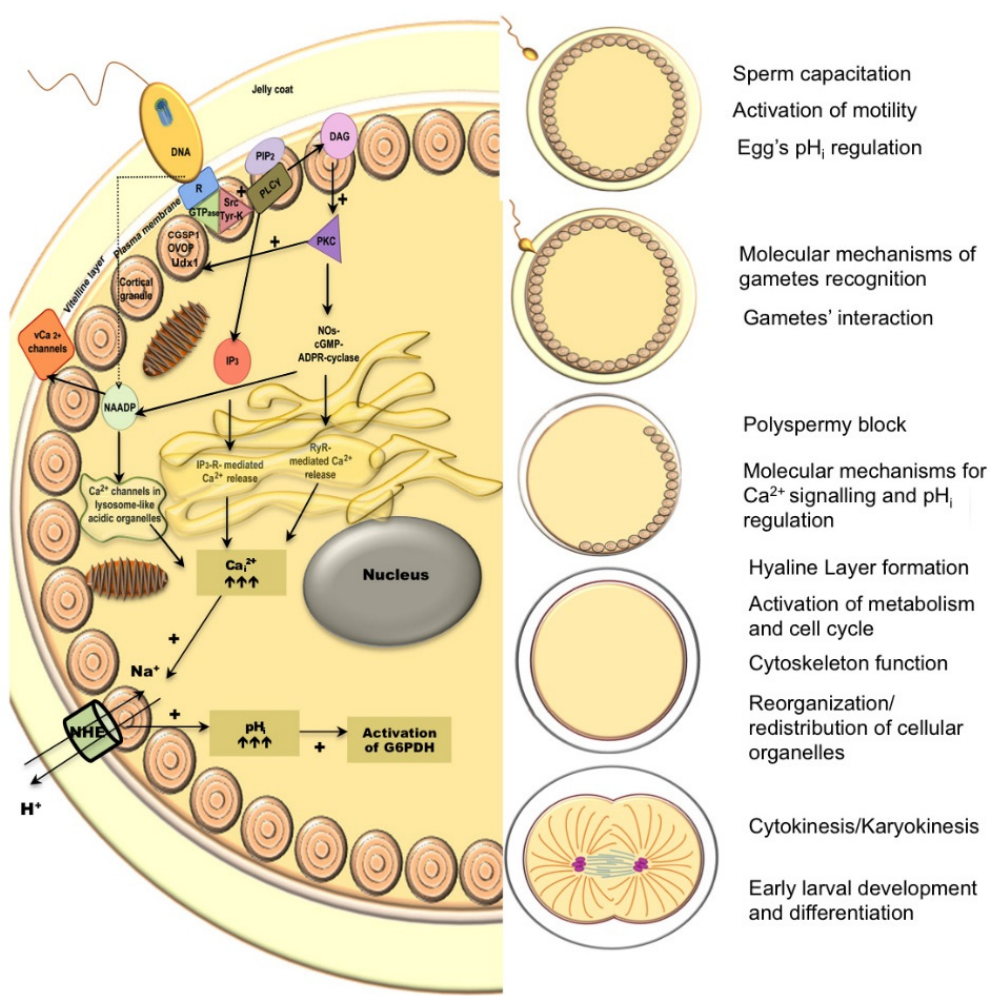
Figure 2. Overview of the main mechanisms at fertilization prone to be susceptible under climate change scenarios. AChR: nicotine acetylcholine receptors; ADPRcyclase: ADPrybosylcyclase; CGSP1: cortical granule serine protease 1; DAG: diacylglycerol; GTPase: G protein; G6PDH: glucose-6- phosphate dehydrogenase; IP 3 : inositol triphosphate; IP 3 R: IP 3 -receptors; NAADP: nicotinic acid adenine dinucleotide phosphate; NHE: Na + -H + exchanger; NOs: nitric oxide synthase; OVOP: ovoperoxidase; PIP 2 : polyphosphatidylinositol 4,5-biphosphate; PKC: protein kinase C; PLC γ : phospholipase C; RyR: ryanodine receptors; TyrK: tyrosine kinase of the Src family. More details of